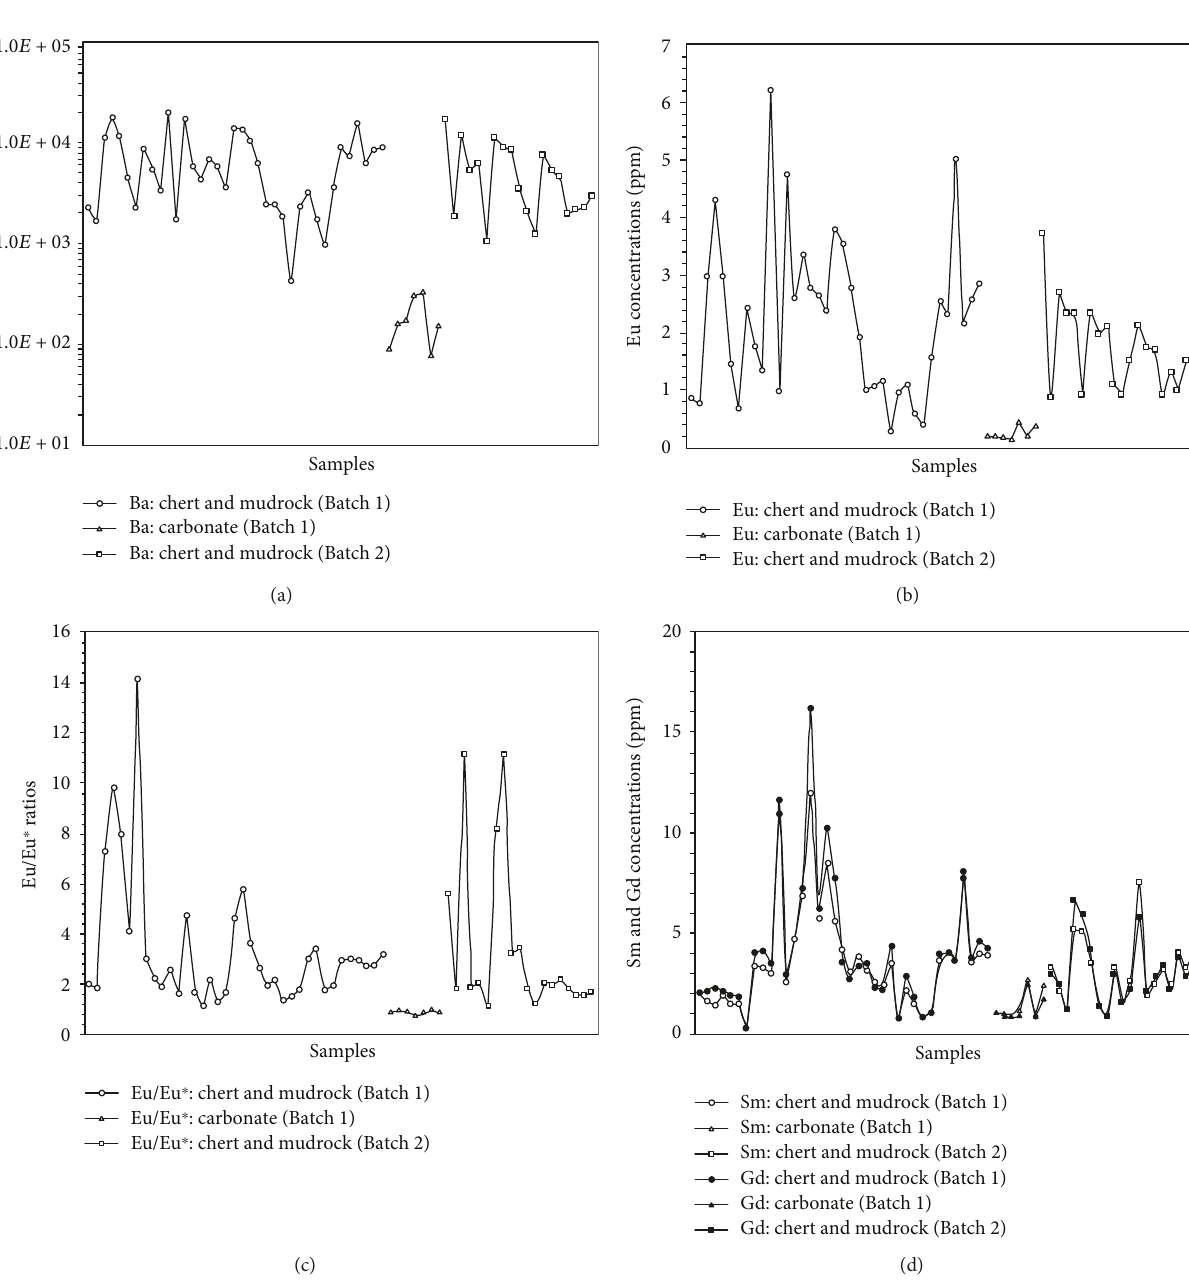
Figure 4: The plots showing values of (a) Ba concentrations, (b) Eu concentrations, (c) Eu/Eu ∗ ratios, and (d) Sm and Gd concentrations in chert and mudrock samples for Batch 1, carbonate samples for Batch 1, and chert and mudrock samples for Batch